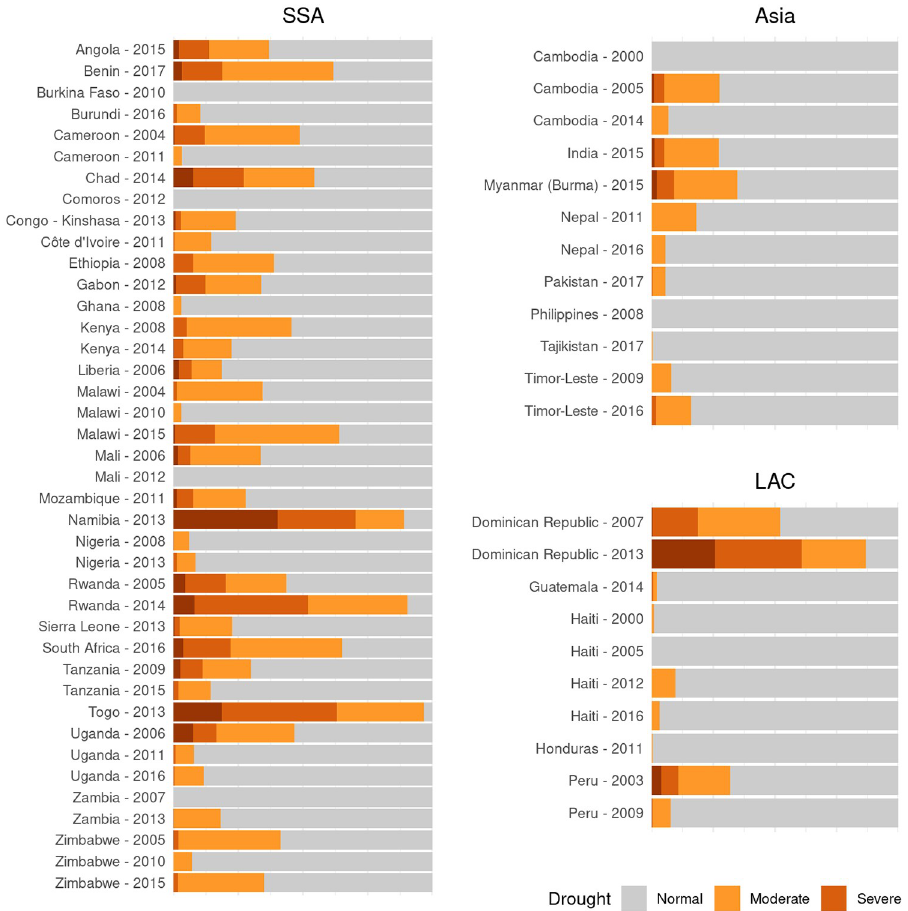
Fig 2. Drought levels. Proportion of each DHS survey exposed to each level of drought